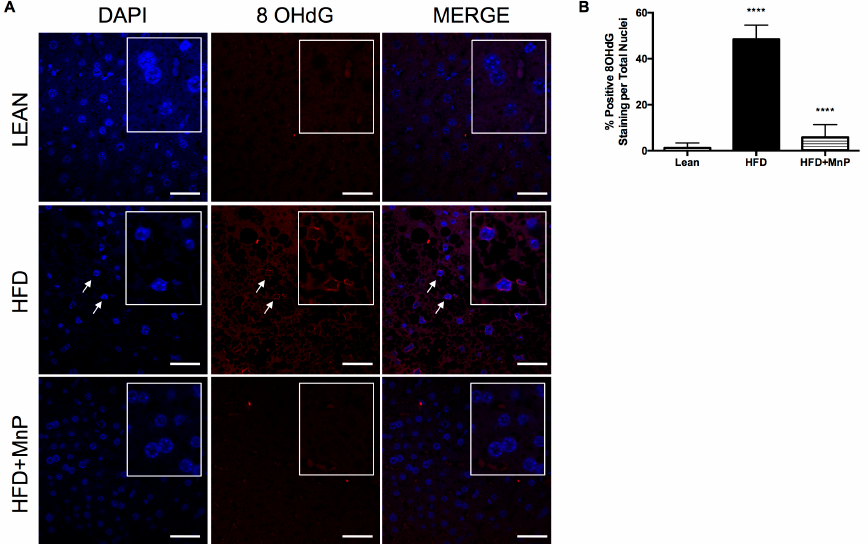
Figure 6. MnP treatment reduces oxidation-induced DNA damage. ( A ) 8-OHdG immunofluorescence staining of livers after 12 weeks of HFD feeding, with or without MnP treatment. Representative images are shown with a 40× magnification. Arrows indicate hepatocyte nuclei positive for 8-OHdG. The inset boxes show a magnified view of the nuclei. ( B ) Quantification of 8-OHdG staining. Data are displayed as mean ± SD, n = 3 mice per group. Three images per section were analyzed using Image J Software (National Institute of Health (NIH), Bethesda, MD, USA). Significance was calculated by one-way ANOVA with a Tukey post-test of multiple comparisons. **** indicates p ≤ 0.0001 between Lean and HFD, and **** indicates p ≤ 0.0001 between HFD and HFD + MnP. Images were created in Photoshop (Adobe Systems Inc., San Joes, CA, USA).